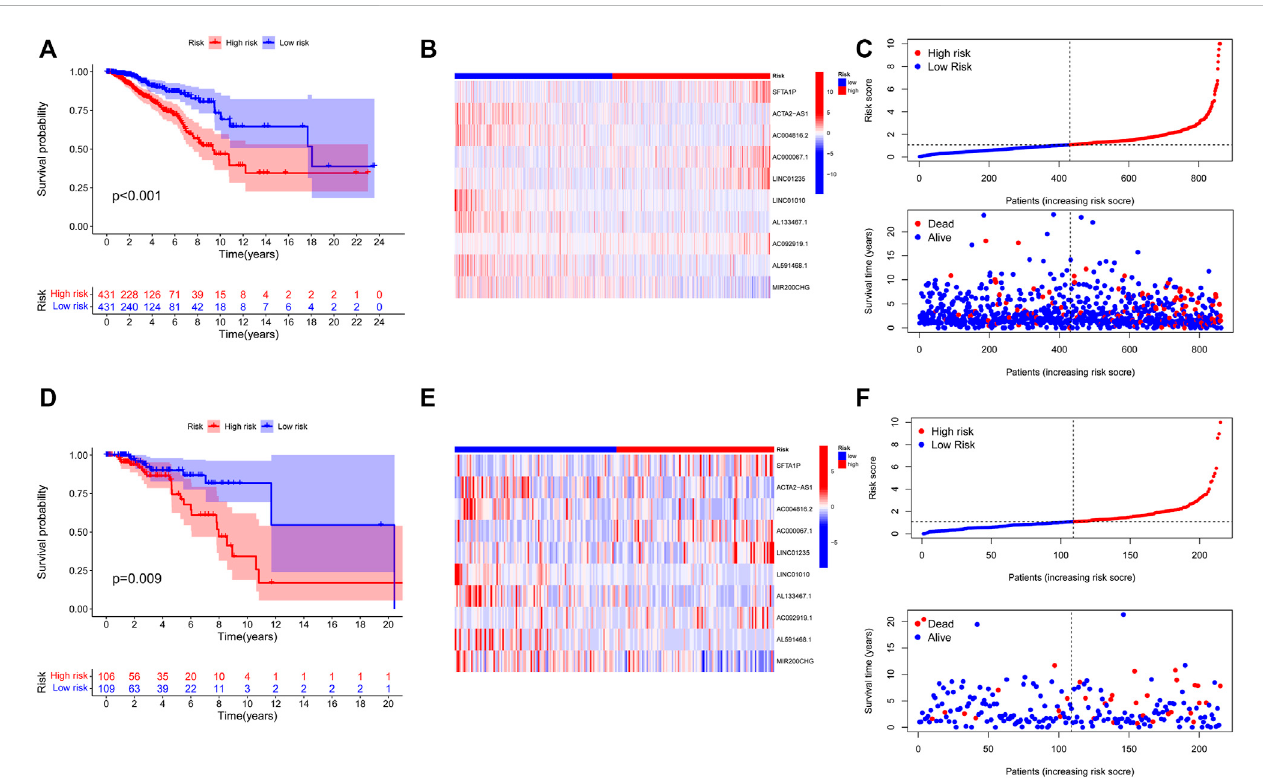
FIGURE 4 ConstructionandvalidationofprognosticsignaturesofNETs-relatedlncRNAs. (A-D) Kaplan – MeiercurvesofoverallsurvivalforBCpatientsbasedonthe risk score in the training (A) and validation (D) cohorts. (B-E) Heatmap of the signature of 10 NETs-related lncRNAs in the training (B) and the validation (E) cohorts. (C-F) Distribution of risk score, OS, and OS status in the training (C) and the validation (F) cohorts. NETs, neutrophil extracellular traps; lncRNAs, long non-coding RNAs; BC, breast cancer; OS, overall